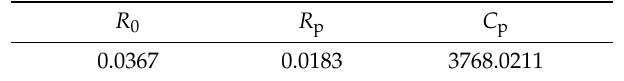
Table 4. O ffl ine parameter identification results of the Thevenin Table 4. Offline parameter identification results of the Thevenin model.